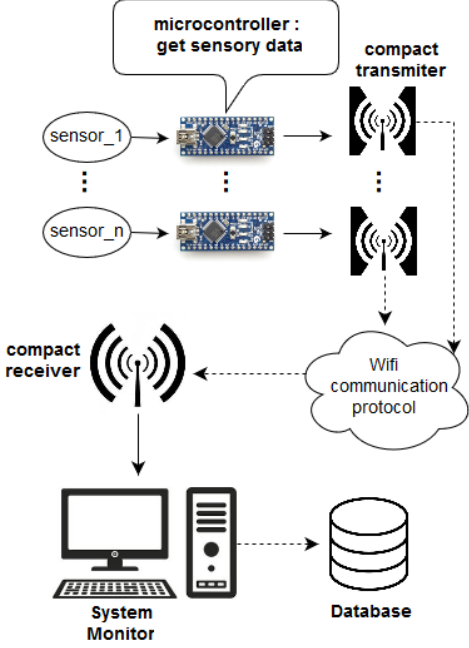
Figure 3: Sensory network architecture. Sensory information is broadcast from several sensors across the environment using a wifi communication protocol to a central